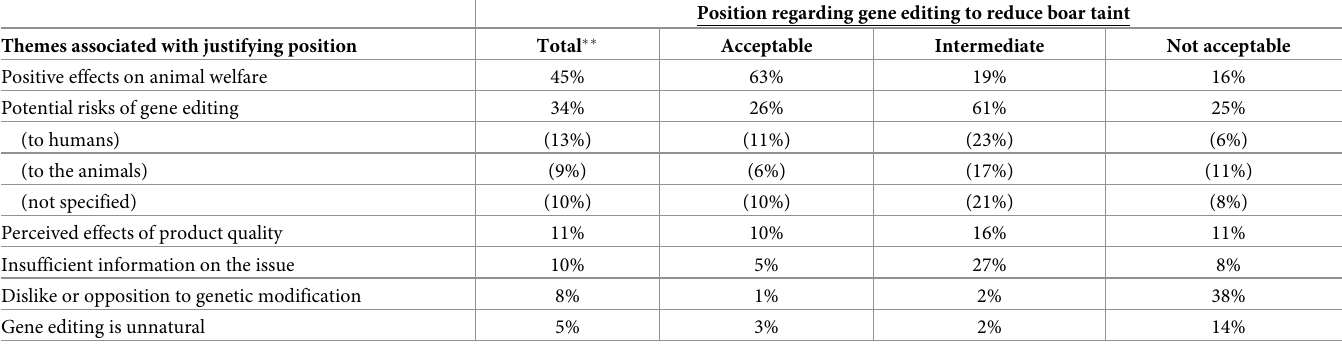
Position regarding gene editing to reduce boar